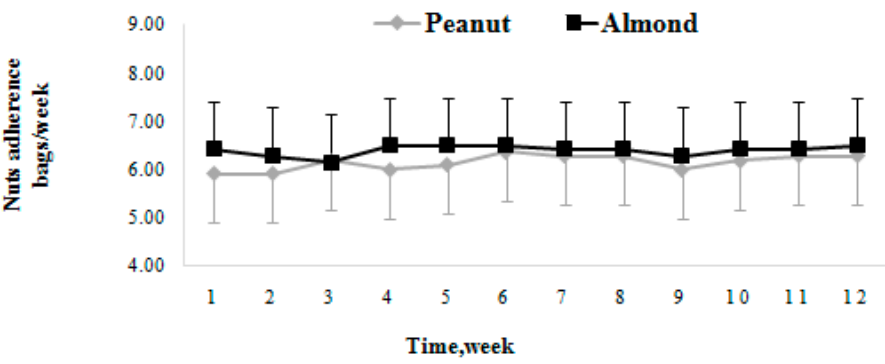
Figure 2. The changing trends of dietary adherence in the Peanut and Almond groups. Values are means, with their standard deviations represented by vertical